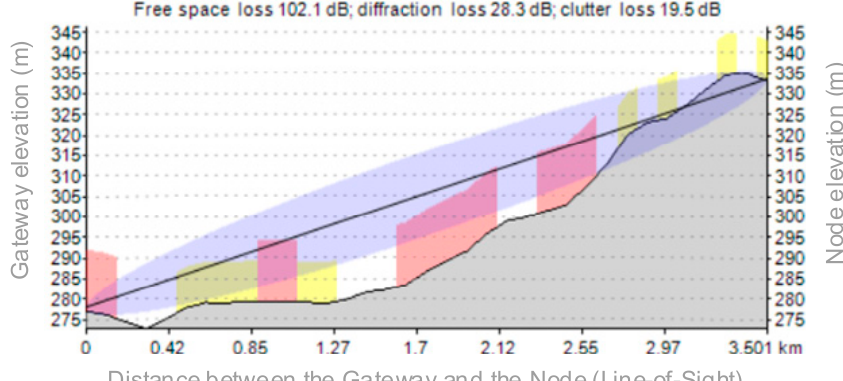
Figure 12. Losses due to the geographical terrain variation for Scenario 2.